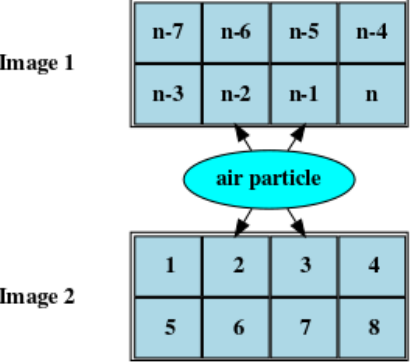
Figure 6. Lagrangian air particle existing on the